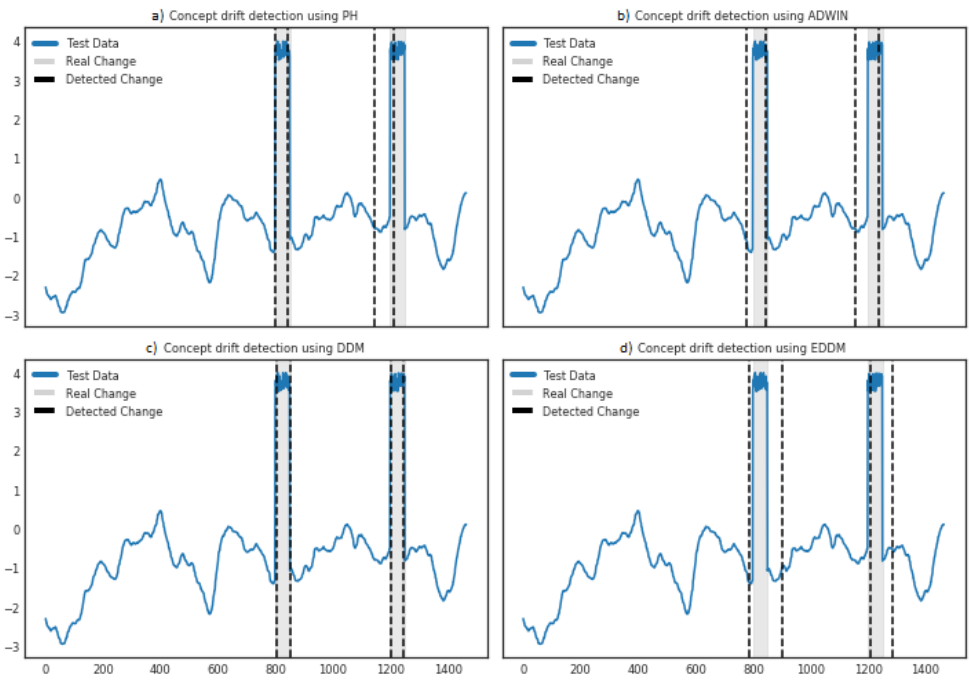
Figure 3. Results for abrupt drift detection, see Section 3.1, where X axis shows occurrence count and Y axis the